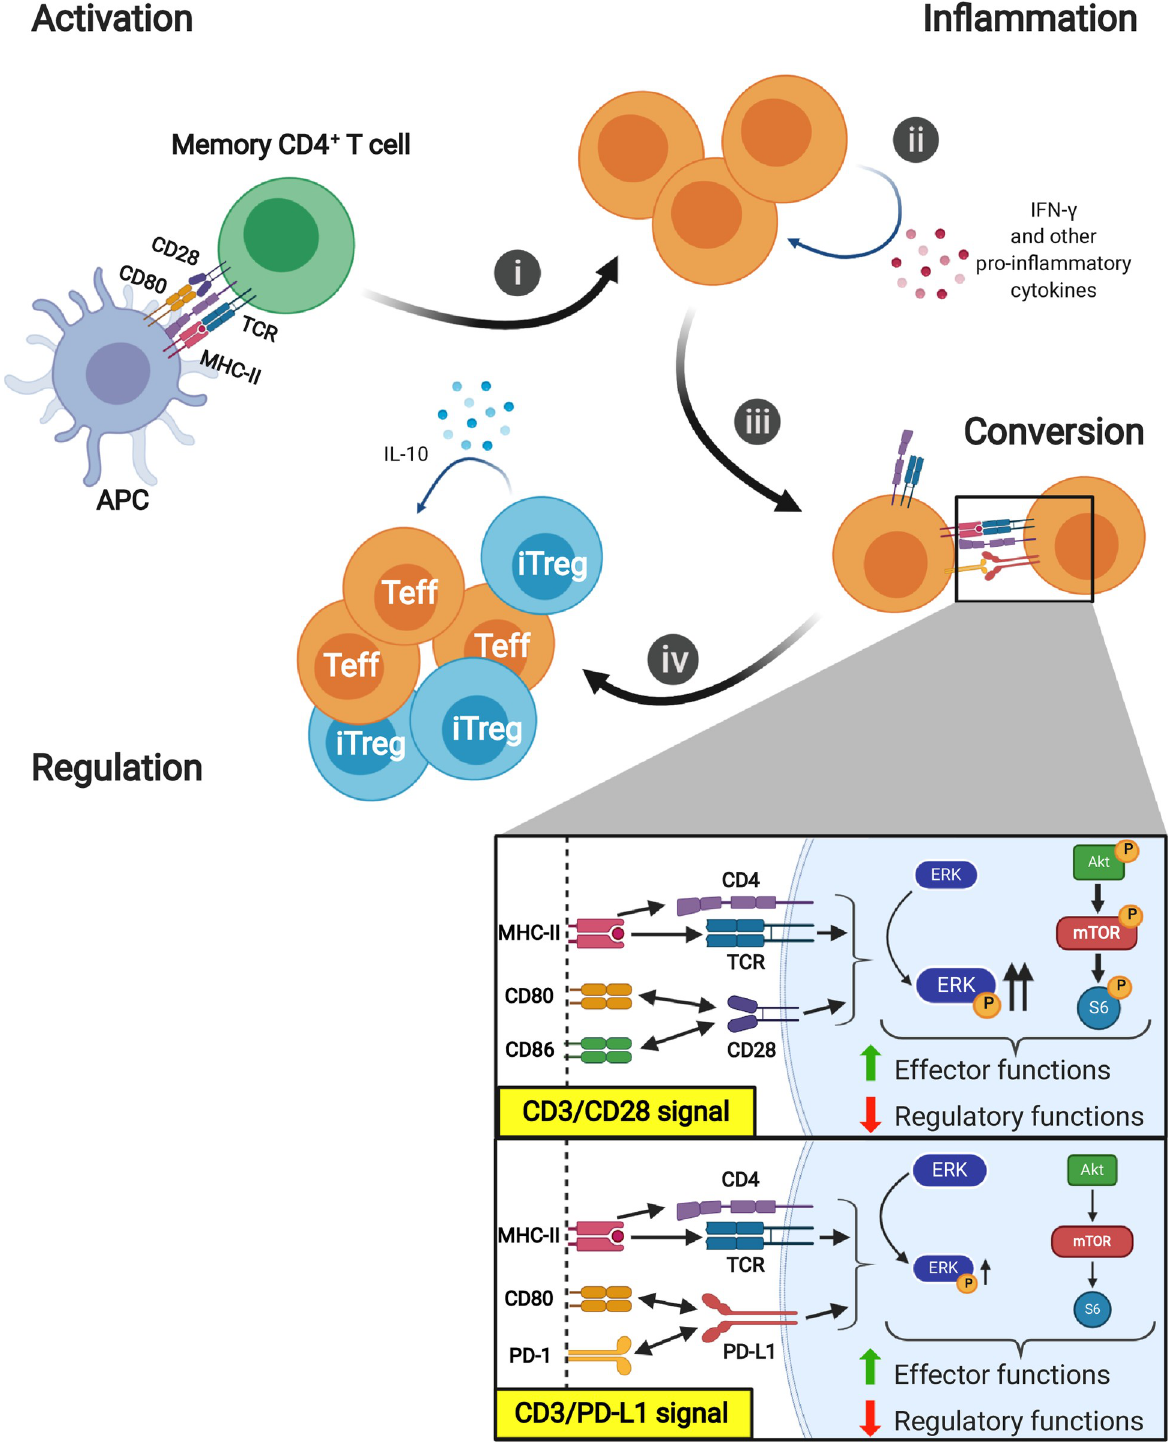
Fig 8. Proposed role of PD-L1 on contraction of activated effector T cells. (i) Activation: Following TCR/CD28 stimulation of memory T cells, MAPK/ERK pathway and AKT/mTOR/S6 pathway are activated. (ii) Inflammation: Activated T cells migrate to the sites of inflammation where they produce large amount of IFN- γ that induce and sustain PD-L1 expression. (iii) Conversion: PD-L1 ligation on effector T cells induces a reverse signal that reduces ERK phosphorylation and attenuates the AKT/mTOR/S6 pathway leading to the conversion into iTregs by up- regulating FOXP3 and CTLA-4 expression and secretion of IL-10. (iv) Regulation: iTregs exert their regulatory functions on effector cells